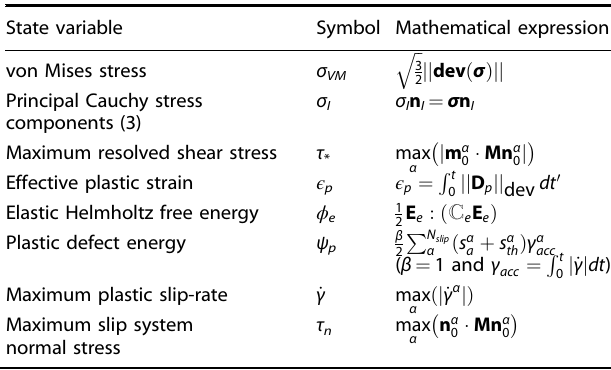
Table 2. List of core state variables used in the probabilistic crack nucleation